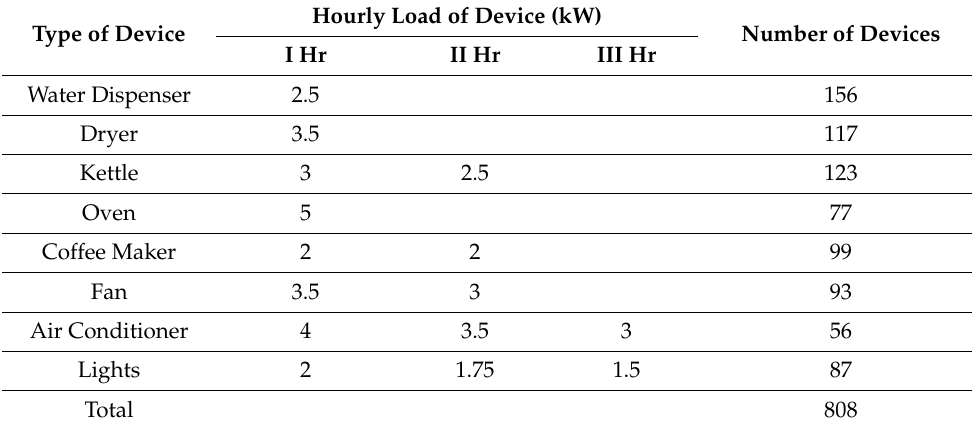
Table 3. Controllable device data in the commercial